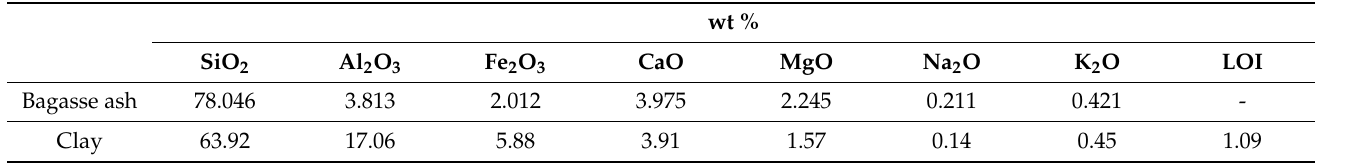
Table 1. Chemical composition of Bagasse ash and China clay.